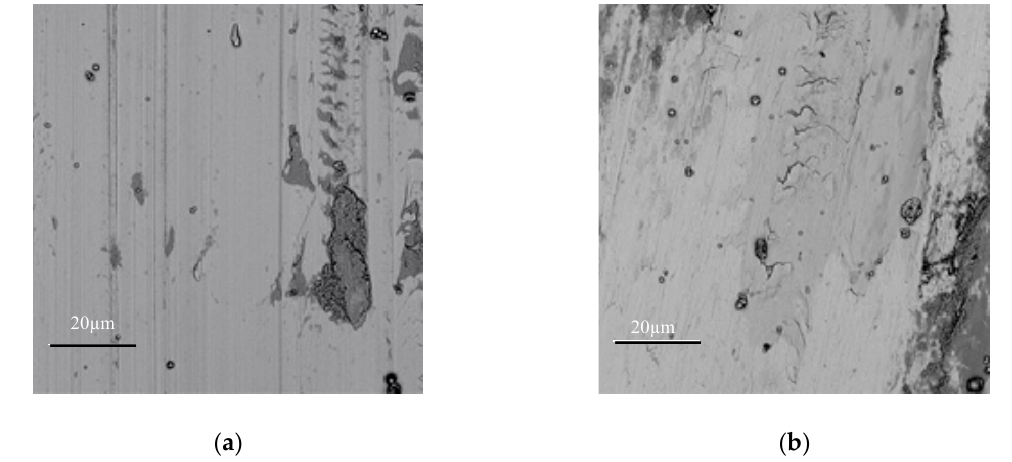
Figure 13. Morphologies of the counter bodies after 2 h wear testing. ( a ) Hardened steel, ( b ) WC/Fe coating.